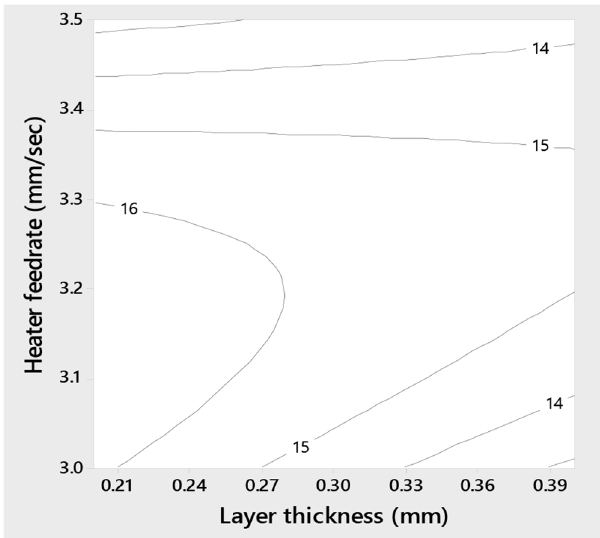
Fig. 14. Contour plot of fatigue strength versus heater temperature and printer feed